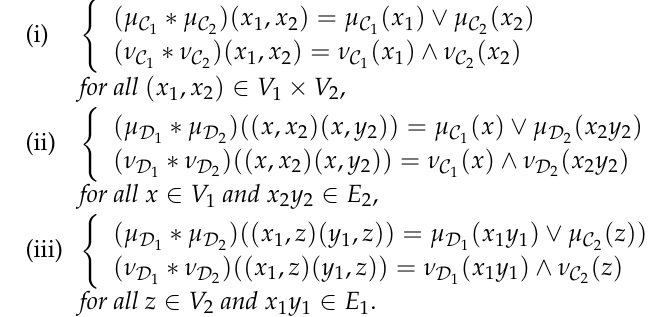
Figure 9. PFGs. Figure 2.8: PFGs.